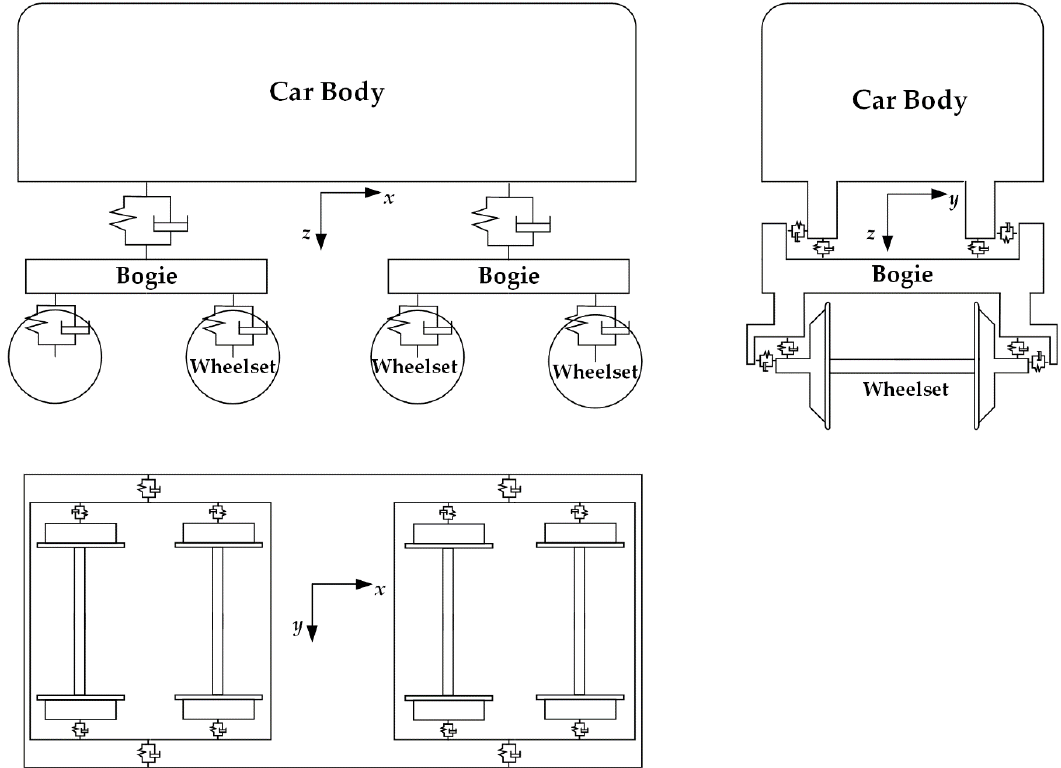
Figure 1. A topological graph of the vehicle model.